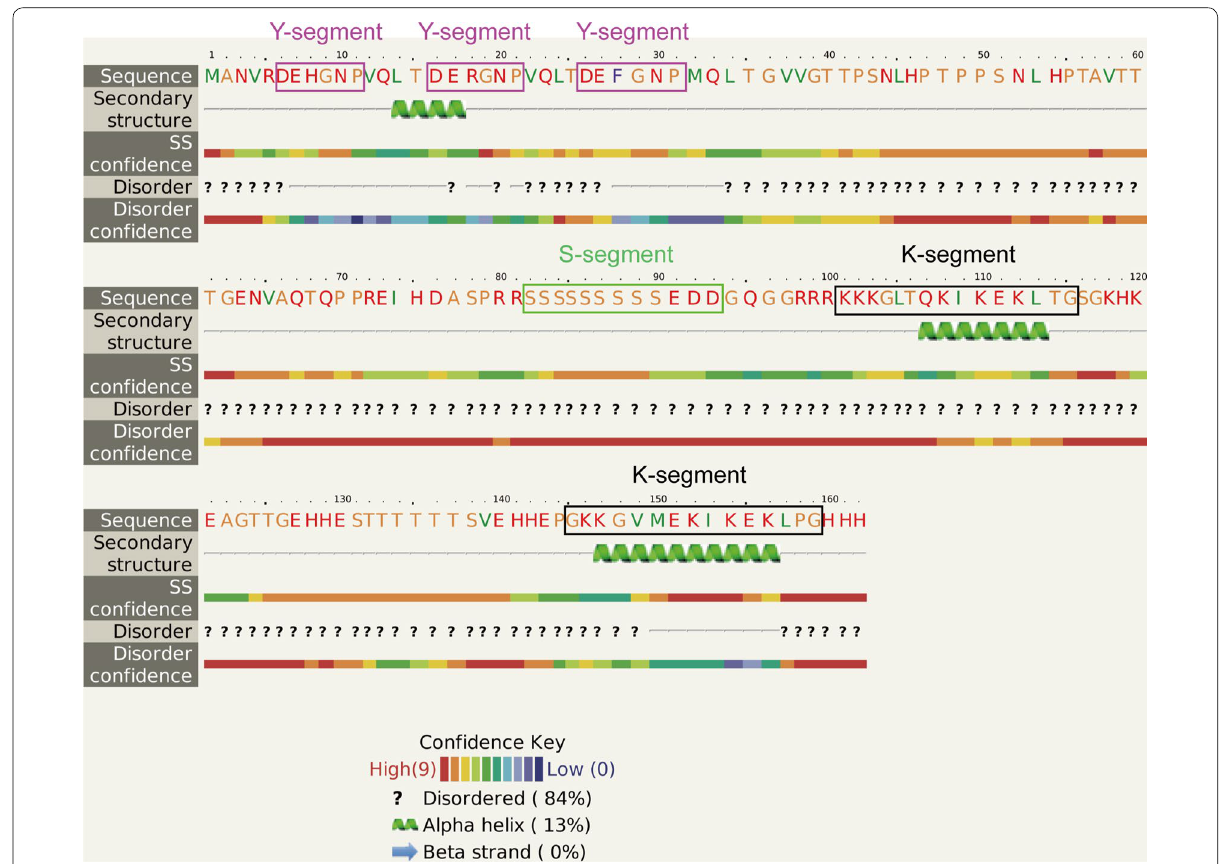
Fig. 1 Deduced amino acid sequence of CsLEA11. The Y-, S- and K-segments are boxed by purple, green and black, respectively